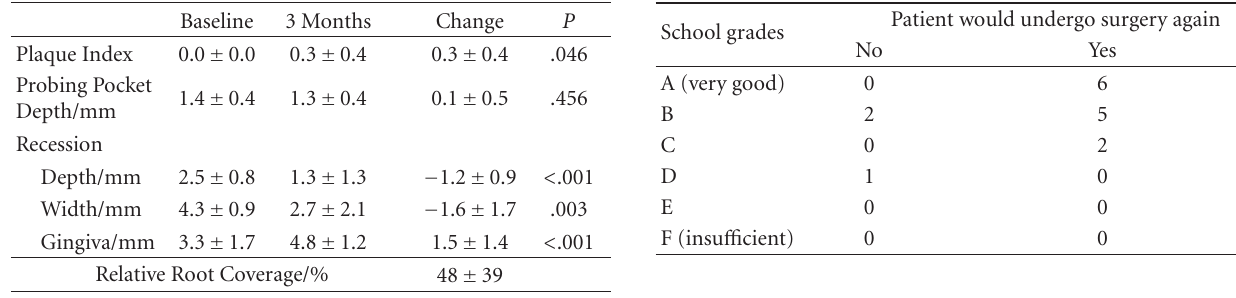
Table 1: Defect characteristics.